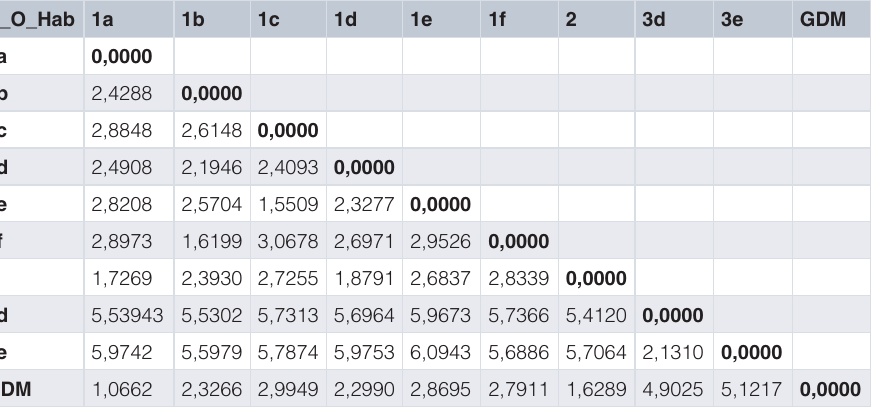
Table 4. Euclidean distance using the overlap operator in Equation